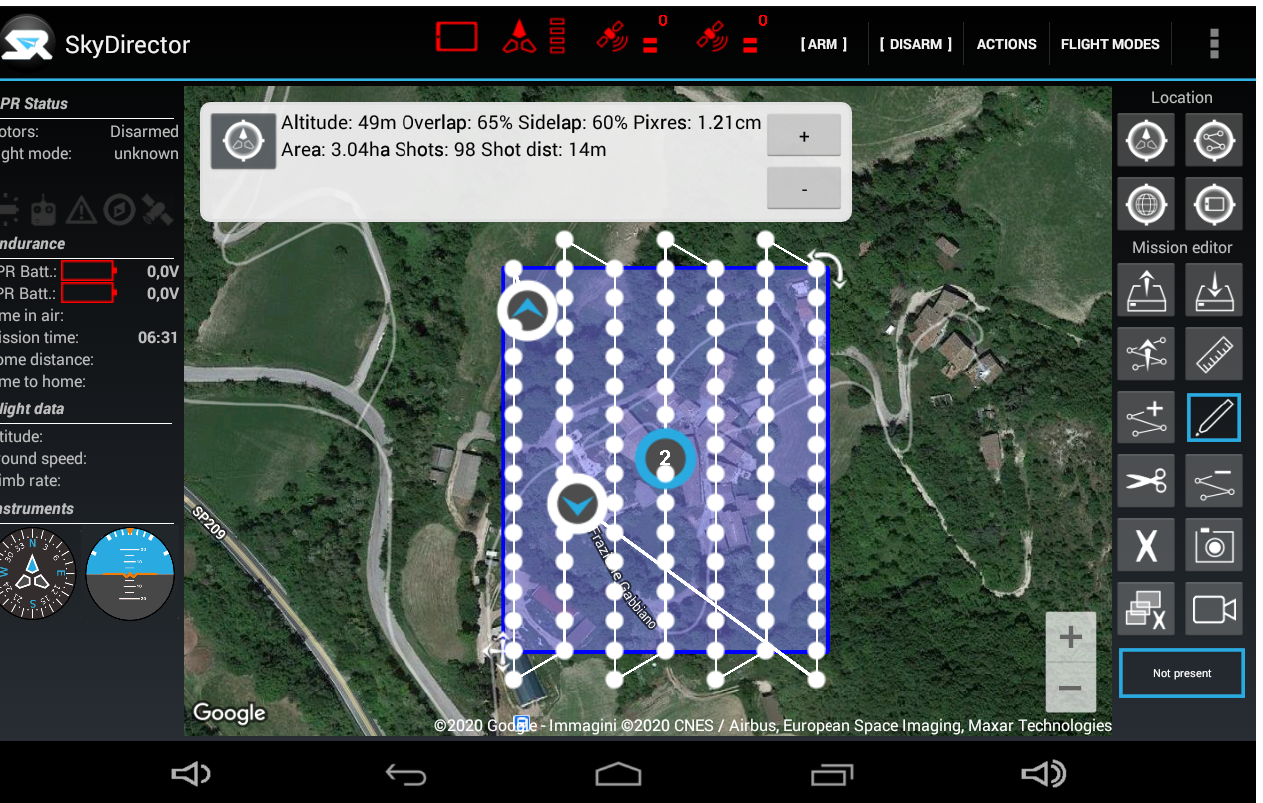
Figure 5. SkyDirector app used for UAV flight plan.